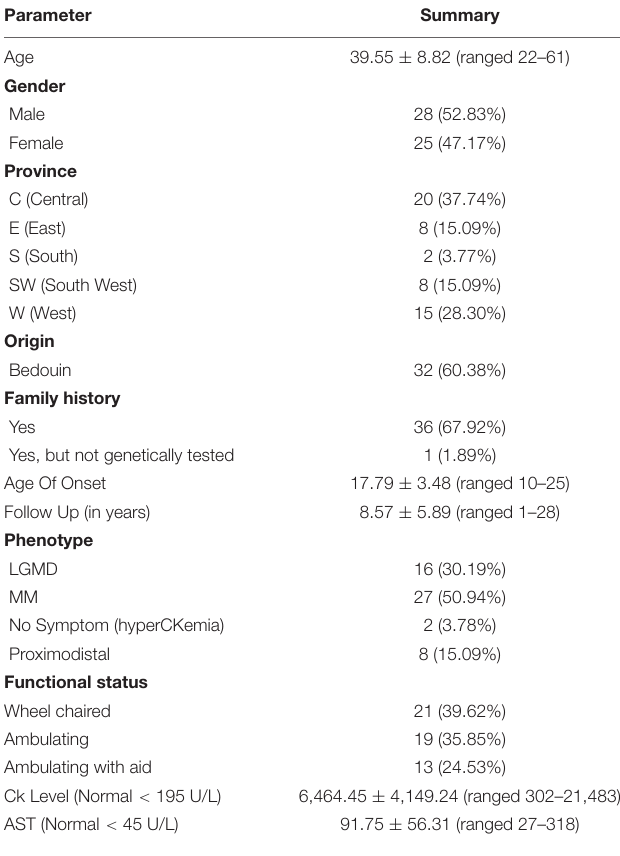
TABLE 1 | Summary of baseline parameter in the study population ( N =